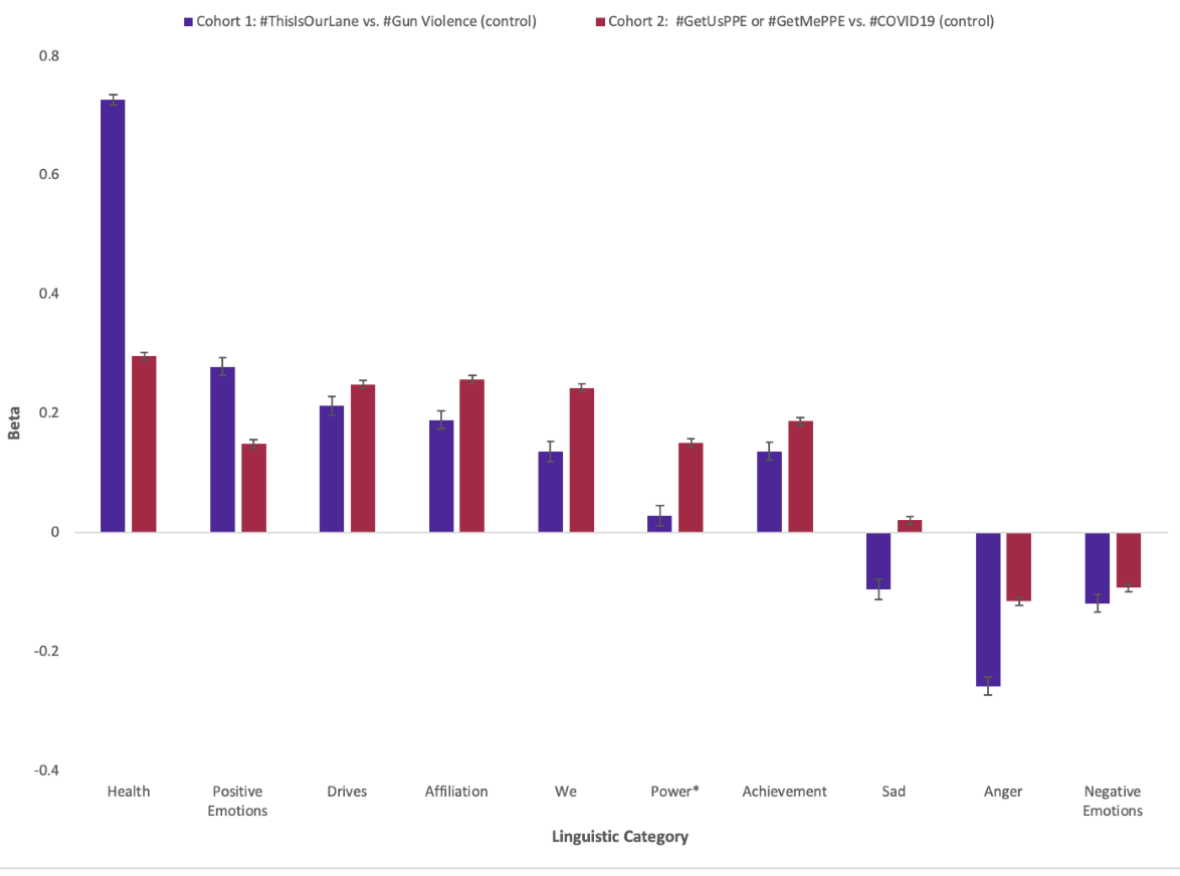
Figure 6. Linguistic correlates of health care–led Twitter hashtag campaigns (#ThisIsOurLane and #GetUsPPE/#GetMePPE) compared with general ones (#GunViolence and #COVID19). Positive beta indicates a strong correlation of the linguistic category with the case compared to the control tweets. *“Power” was not significant at P <.001 for cohort